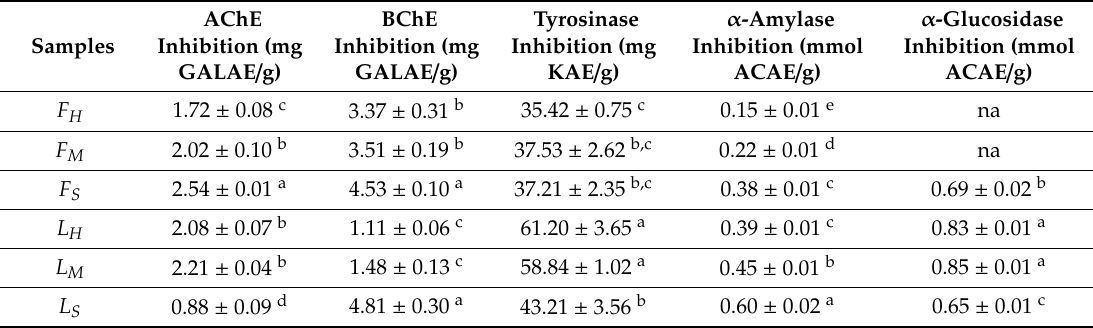
Table 7. Enzymatic inhibition assays for leaf and fruit Elaeagnus angustifolia extracts.